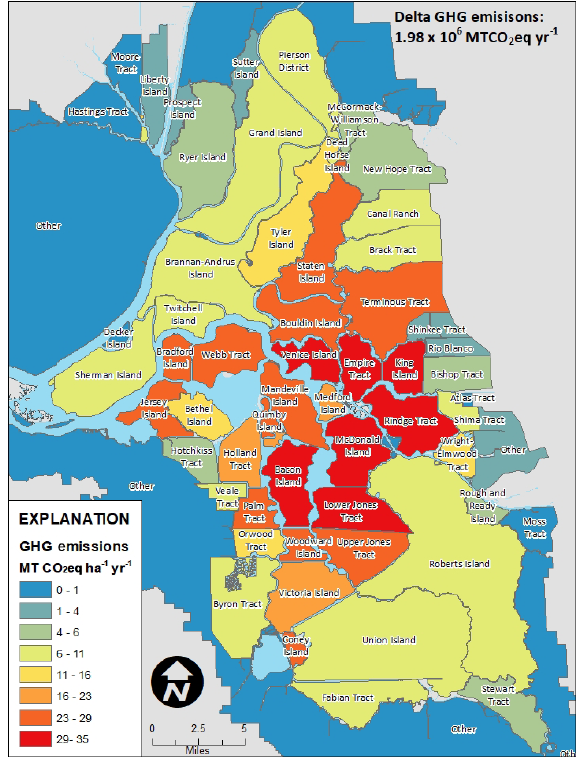
Figure 2. Present-day estimated annual GHG emissions in MTCO 2 eq.ha − 1 yr − 1 .